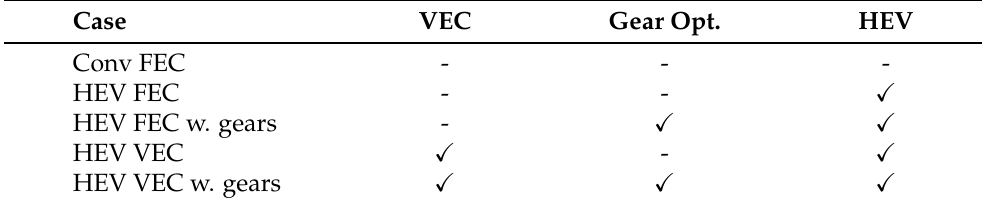
Table 4. HEV cases